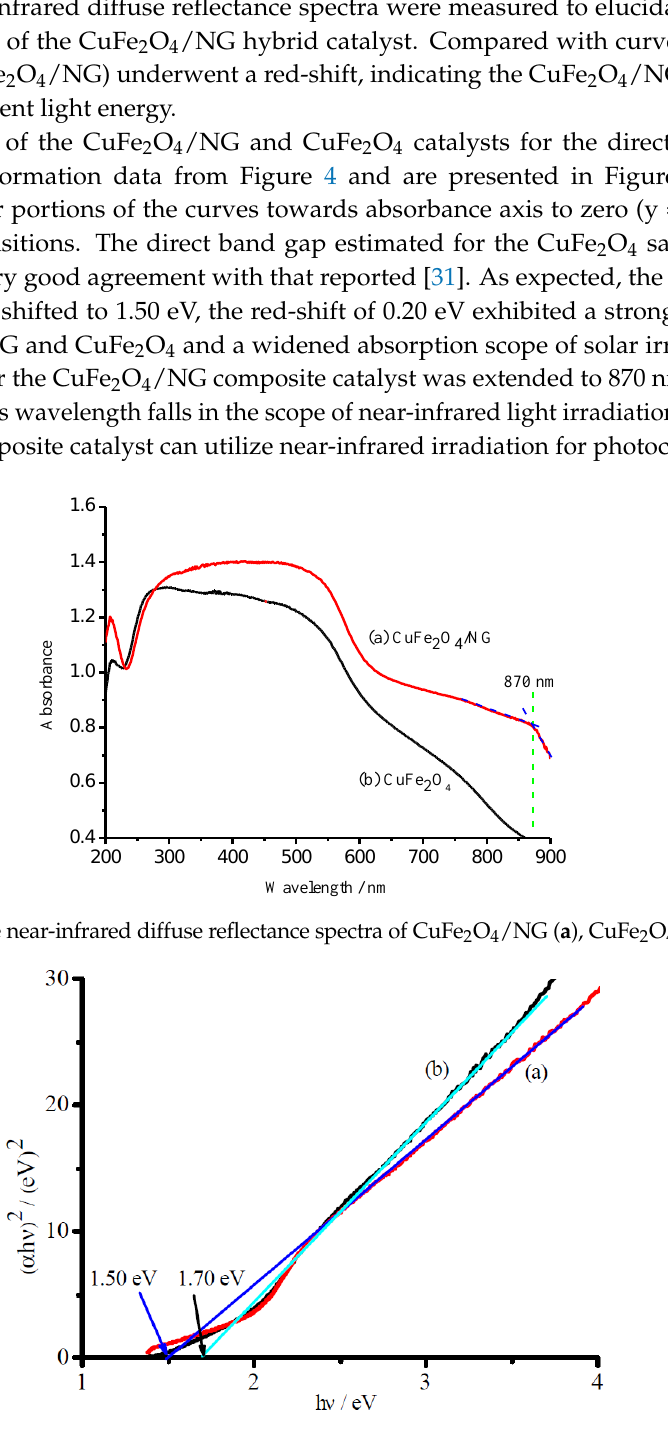
Figure 5. Tauc-plots for direct transition of CuFe 2 O 4 /NG ( a ), CuFe 2 O 4 ( b ) catalysts.